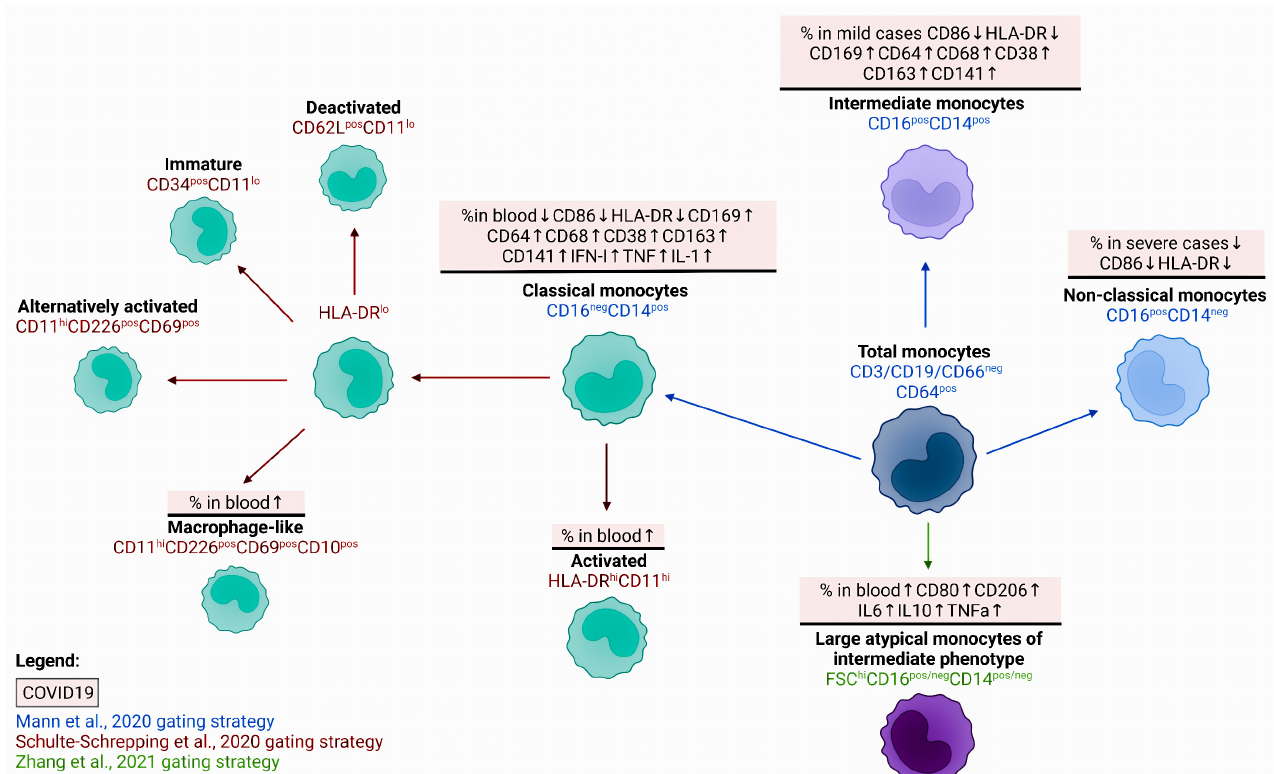
Figure 2. Major phenotypic changes within monocytes and their main subsets during acute COVID-19. Human peripheral blood monocytes are divided into three major populations: classical (CD14+CD16 − ), non-classical (CD14dimCD16+), and intermediate (CD14+CD16+). Currently, the data on monocyte subsets dynamics in COVID-19 are very contradictory, but all subsets were characterized by reduced expression of co-stimulatory and antigen-presenting molecules (CD86 and HLA-DR, respectively) and increased levels of different activation markers, including CD38, CD64, CD163, etc.